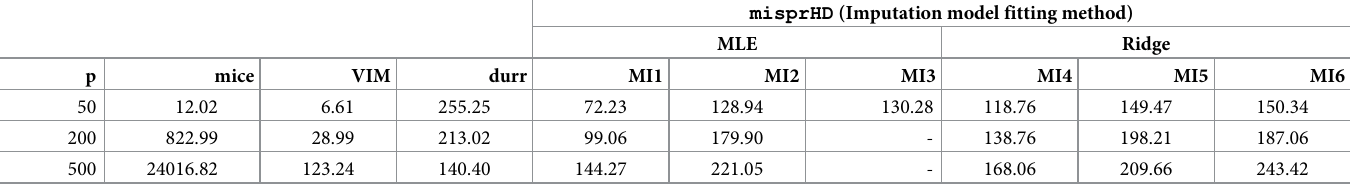
Table 3. Average (of S = 200 elapsed time values) processing time (in seconds) required by different algorithms to impute one dataset with 10% missing